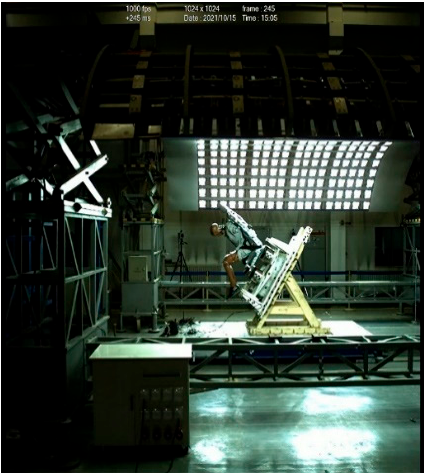
Figure 6. A frame during the process of the